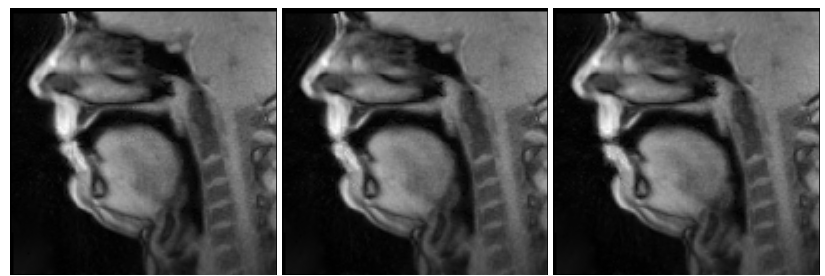
Figure 3. Midsagital real-time MRI image sequence of speaker 8545 articulating /p/ as in the nonsense word [ p 5net5] . The images have been automatically identified considering the corresponding time interval annotated based on the audio recorded during the acquisition. Note the closed lips, throughout and their opening, in the last frame, to produce the following /5/ .